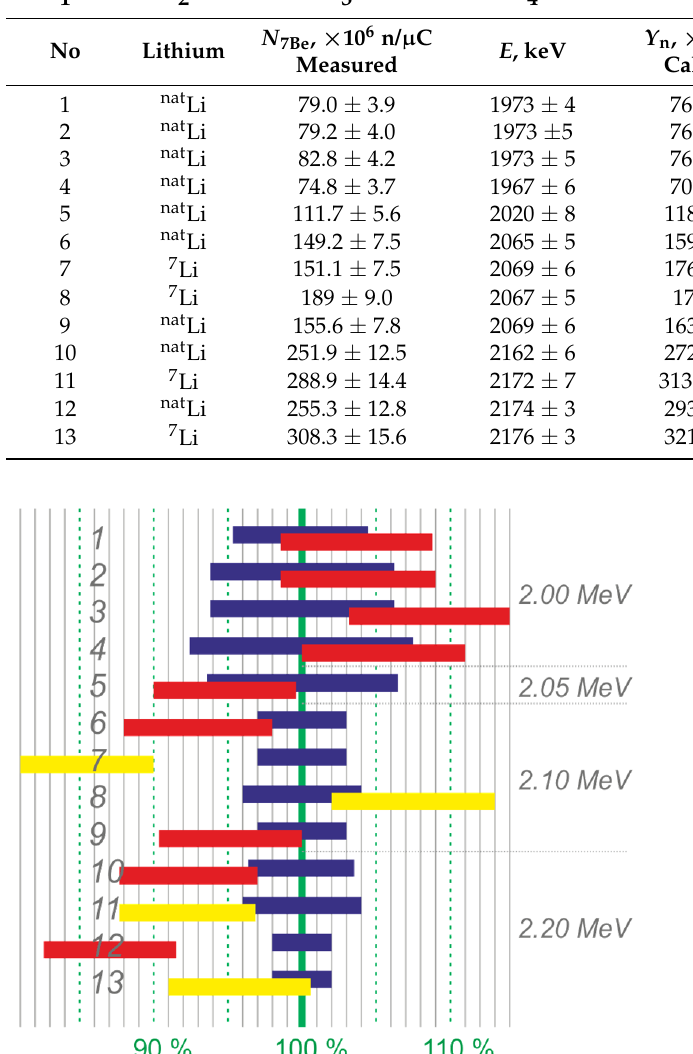
Figure 8. A comparison of the measured neutron yield with the calculated one. From top to bottom—targets in order, blue rectangles—intervals of the calculated neutron number, red and yellow—intervals of the measured neutron number (red—natural lithium, yellow—enriched with lithium-7 isotope). On the right: the characteristic values of the proton